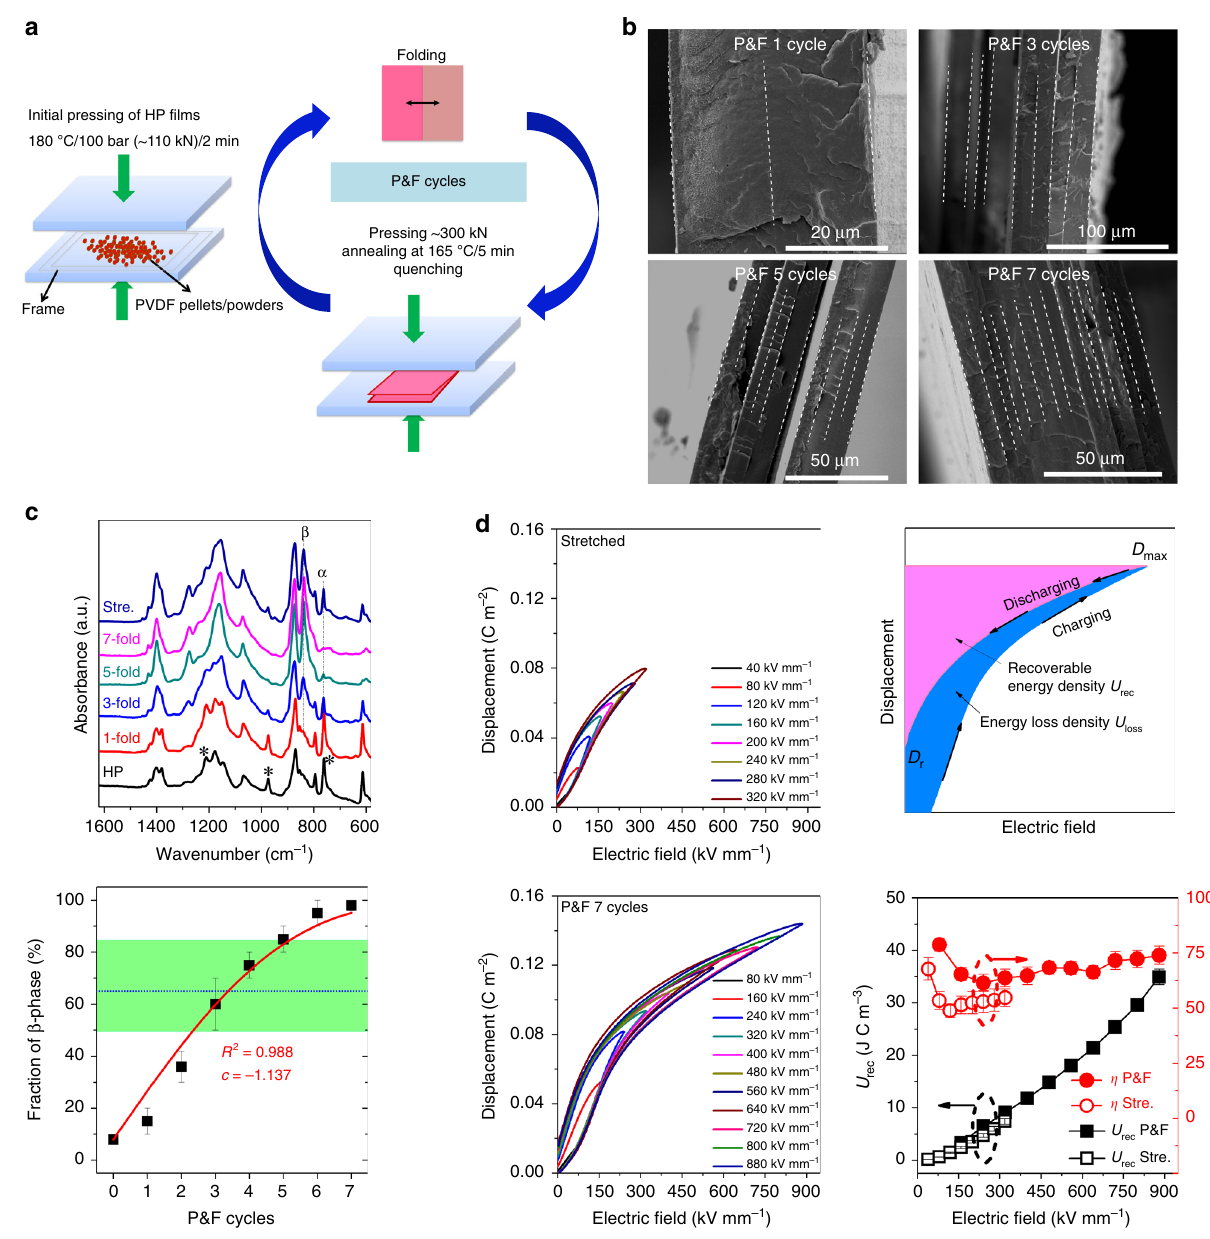
Fig. 1 Pressed and folded poly(vinylidene fl uoride) compared with stretched samples. a Schematic demonstration of P&F technique. b Cross-sectional SEM images of P&F samples folded at 165 °C and 300 kN after different numbers of folding cycles. A fi ne and discrete layered structure is generated during P&F. c The evolution of crystalline phases revealed by the FTIR absorbance spectrum. The initial hot-pressed (HP) fi lms mainly crystallized into α -phase with characteristic peaks at 764, 975 and 1212 cm − 1 highlighted by asterisks and transformed to about 98% β -phase (strong peak at 840 cm − 1 ) after seven folding cycles. The horizontal green shaded area indicates the reported values of fraction of β -phase in commonly stretched PVDF fi lms, the blue dashed line represents the fraction of β -phase for the stretched fi lm in this work and the continuous line is the best fi t of the experimental P&F data with Eq. 2 using c as free parameter ( f β h were set at 8% and 0.6, respectively). d A comparison of electric energy storage properties of P&F and stretched fi lms, which 0 and includes unipolar ferroelectric hysteresis loops, schematic calculations of stored energy of ferroelectric materials and the recoverable energy density U rec and energy ef fi ciency η of P&F and stretched fi